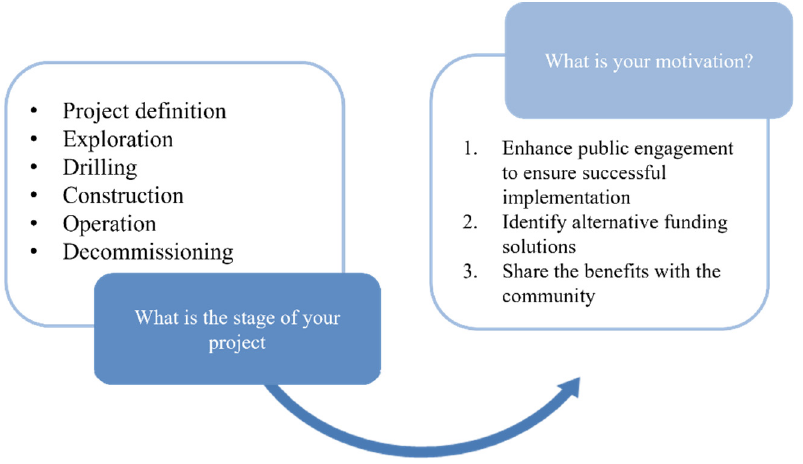
Figure 10. Decision tree’s first two questions.